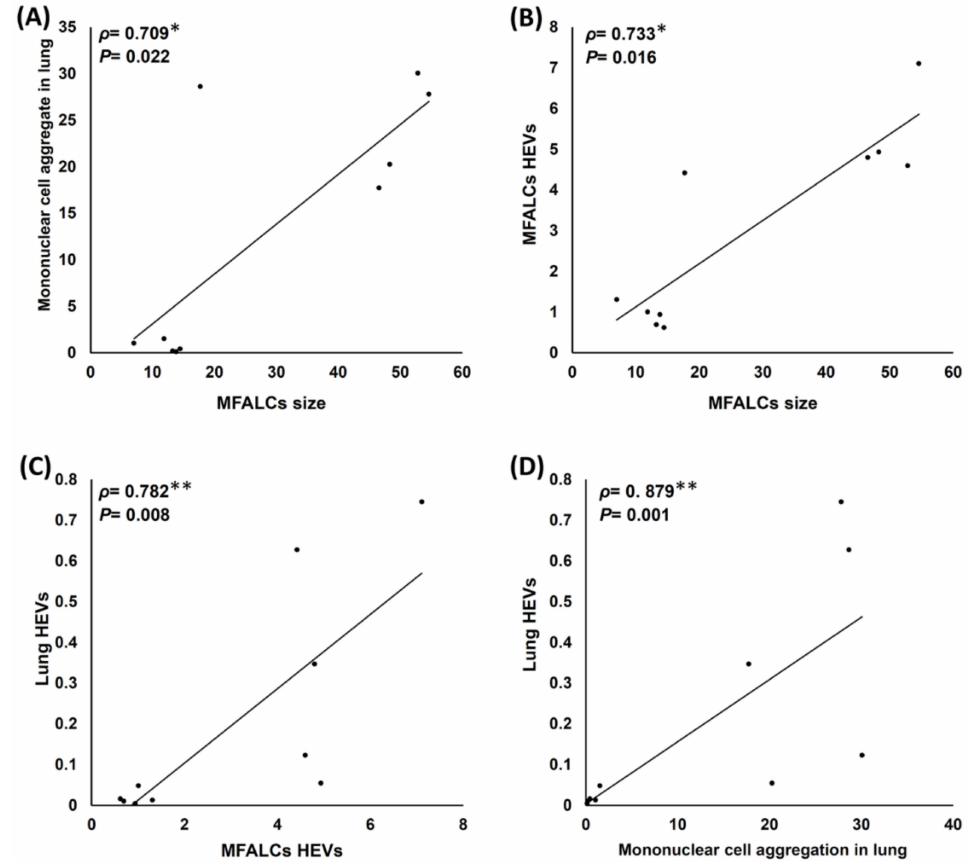
Figure 7. Analysis of the correlations among histoplanimetrical measurements of the lungs and mediastinal fat associated-lymphoid clusters (MFALCs) in the female Lpr mice. ( A , B ) Representative graphs showing Spearman’s correlations among the size of MFALCs with mononuclear cell aggregates in the lung ( A ) and HEVs in the MFALCs ( B ). ( C , D ) Representative graphs showing Spearman’s correlations among the lung HEVs with MFALC HEVs ( C ) and mononuclear cell aggregation in the lungs ( D ); The data were analyzed by the Spearman’s correlation test, where n = 10, ρ : Spearman’s rank-order correlation coefficient. * Significant, p < 0.05, ** Highly significant, p <